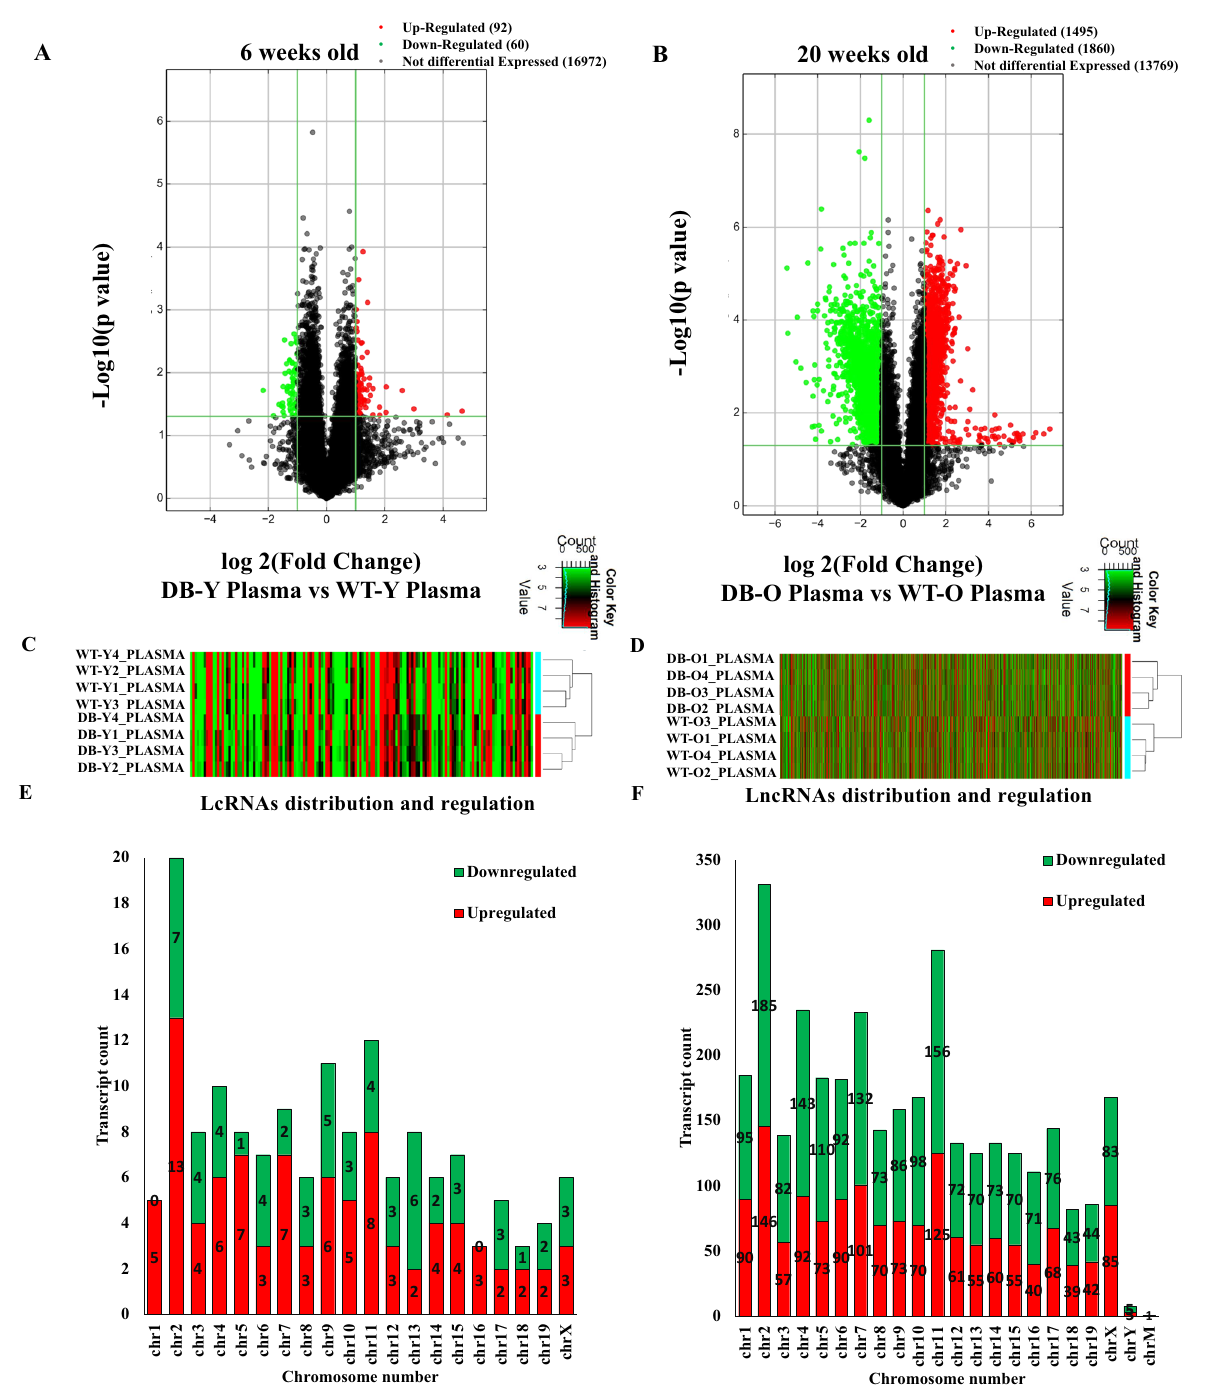
Figure 2. The profiling of deregulated lncRNAs in the plasma of db/db mice with and without diabetic cardiomyopathy compared with controls. (A,B) Volcano plots showing differently expressed lncRNAs in 6 and 20-week-old db/db mice, respectively, compared with controls. The db/db mice develoed early diabetic cardiomyopathy at 20 weeks old. The red and green points represent up- and down-regulated lncRNAs, respectively. The horizontal green line depicts *P ≤ 0.05 (n = 12–13 mice/group), whereas the vertical green line shows a twofold change of up and down. (C,D) Hierarchical cluster analysis presenting differentially expressed lncRNAs between 6 and 20-week-old db/db and control mice, respectively. Colors of red and green represent up- and down-regulated lncRNAs with changes larger than twofold, respectively. (E,F) Chromosomal distribution of deregulated lncRNAs in 6 and 20-week-old db/db mice, respectively. Colors of green and orange represent up- and down-regulated